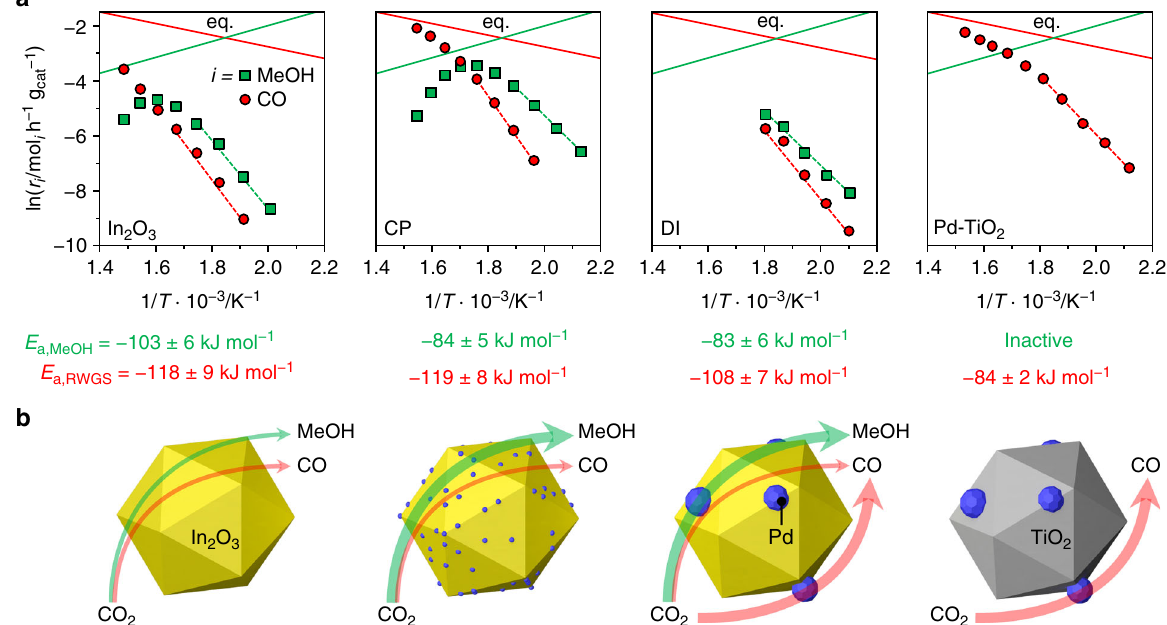
Fig. 5 Activation energies and palladium role for palladium-promoted In 2 O 3 catalysts. a Arrhenius plots and calculated apparent activation energies ( E a ) for CO 2 hydrogenation to methanol (green) and the RWGS reaction (red) over In 2 O 3 , CP, DI, and Pd-TiO 2 catalysts. Data regression was performed in the region outlined by the dashed lines. Solid lines indicate the thermodynamic equilibria of the two independent reactions. b Schematic representation of the distinct role of palladium in equilibrated CP and DI systems with In 2 O 3 and Pd-TiO 2 as references. The thickness of the arrows qualitatively indicates the products formation rates. Reaction conditions: P = 5 MPa, H 2 :CO 2 = 4, and WHSV = 48,000 cm 3 STP h − 1 g cat − 1